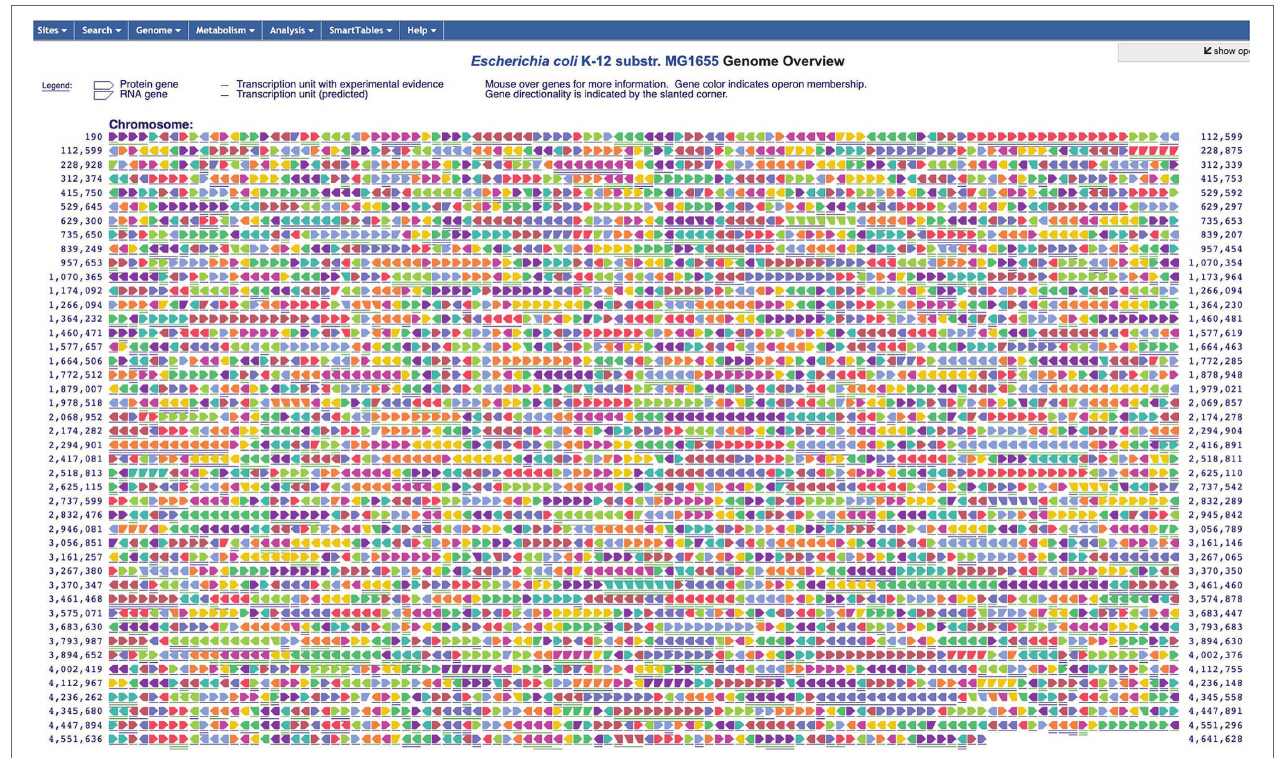
FIGURE 5 | The Genome Overview diagram captures an entire genome with each arrow representing a single gene; neighboring genes that are part of the same operon are displayed in the same color. Arrow sizes are not to